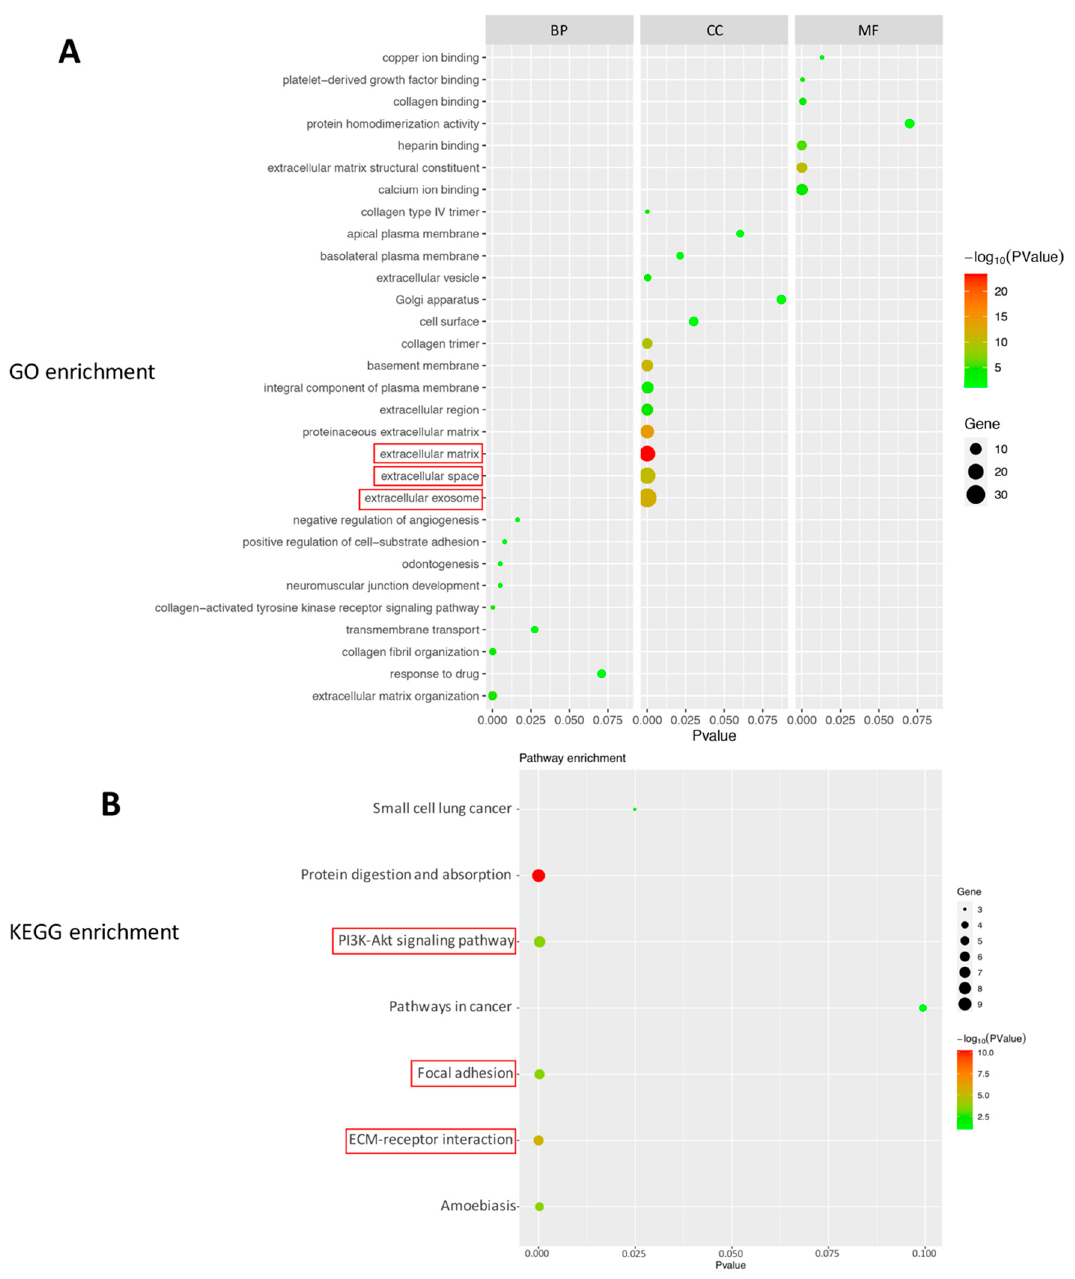
Figure 4. Enrichment analysis of top 55 up-regulated genes based on DAVID bioinformation resources. ( A ) Bubble plot of the enriched GO terms: cellular component terms (CC), molecular function terms (MF), biological process terms (BP). The first three pathways with the most genes (smaller p value), and which may be related to protection of photoreceptor cells are as follows: extracellular exosome, extracellular space, and extracellular matrix (red box). ( B ) Bubble plot of the enriched KEGG pathways. The pathways which may be related to protection of photoreceptor cells are as follows: PI3K–Akt signaling pathway. In addition, there are PI3K–Akt signaling pathway-related pathways: focal adhesion, ECM-receptor interaction (according to the map of PI3K–Akt signaling pathway, https://www.genome.jp/kegg-bin/show_pathway?rno04151 (accessed on 18 June 2021). The colors of the nodes are illustrated from red to green in descending order of –log10 ( p value). X-axis: signaling pathway or function; Y-axis: percentage of the number of DEGs assigned to a term among the total number of DEGs annotated in the network; Bubble size: number of DEGs assigned to a pathway or function; Color: enriched p value.